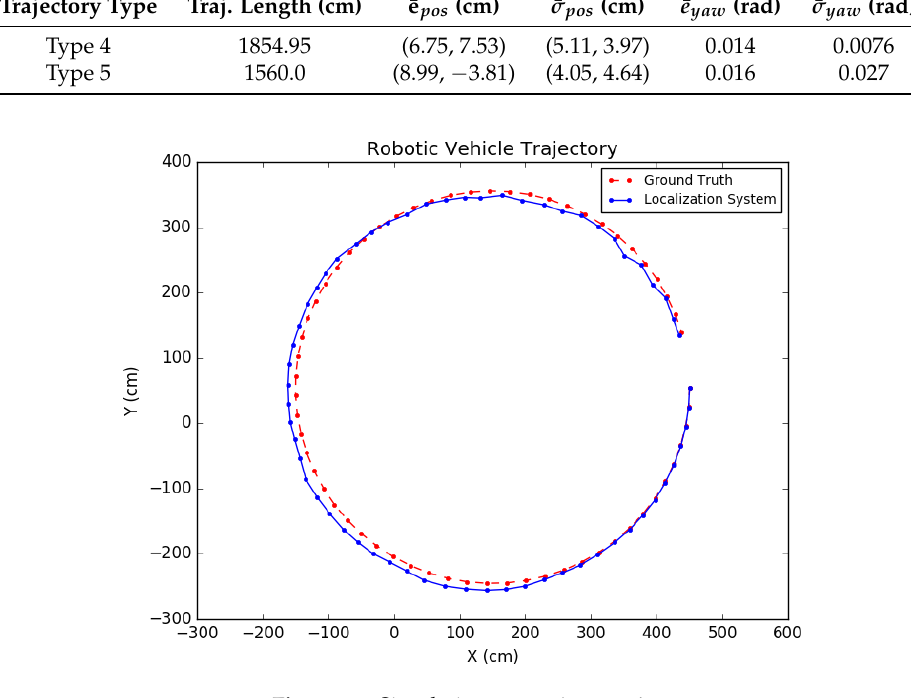
Figure 22. Simulation test trajectory